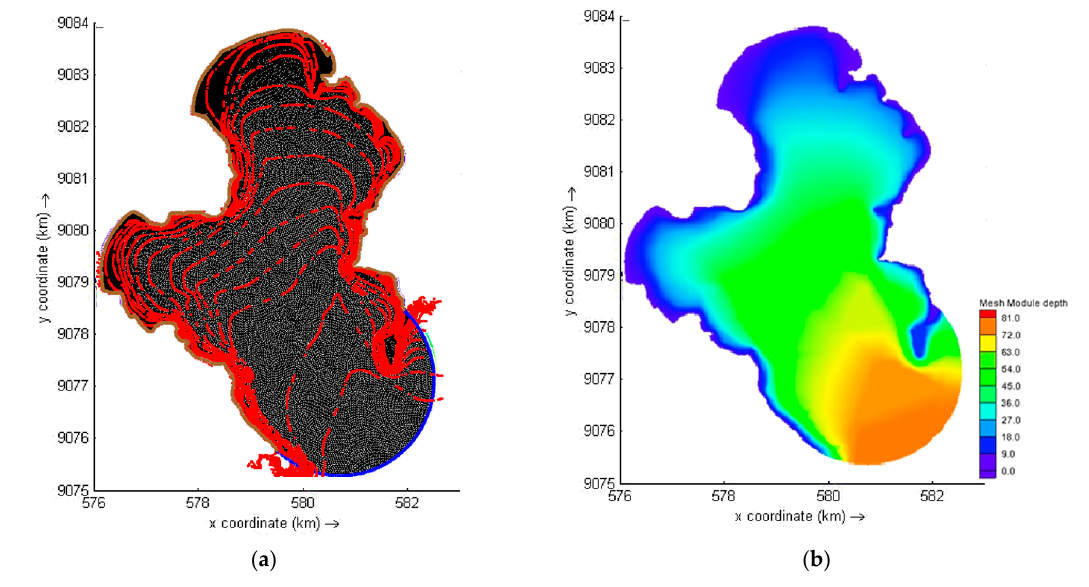
Figure 9. Finite Element Meshing ( a ) and Bathymetry Prigi Bay ( b ).